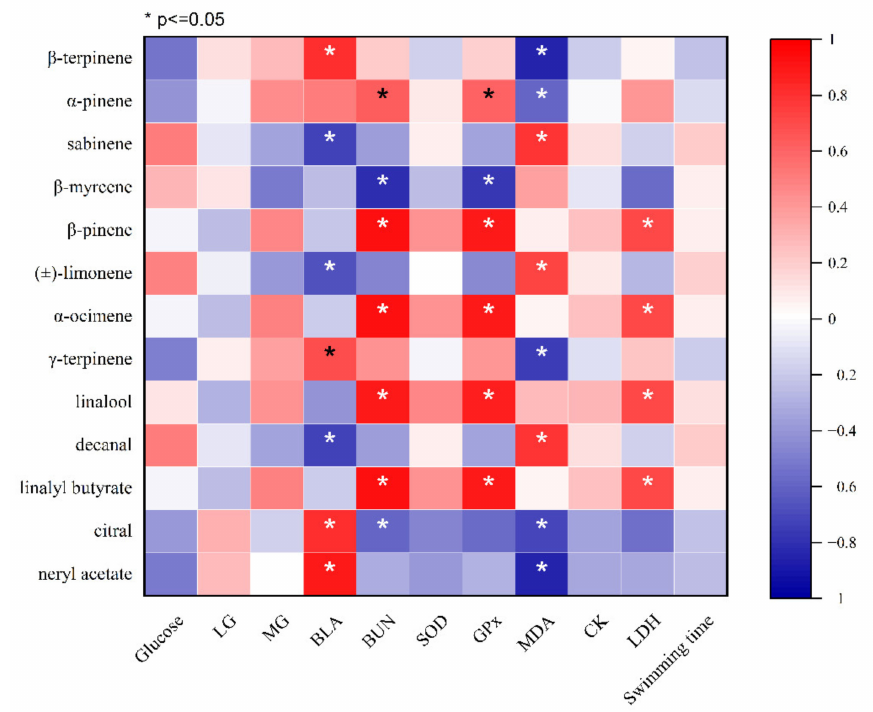
Figure 7. Pearson correlation analysis between exercise performance, fatigue-associated oxidative stress, energy supply, metabolite accumulation, and muscle injury indices. Blue color indicates a negative correlation, and red color indicates a positive correlation. * indicates a significant correlation between groups ( p <